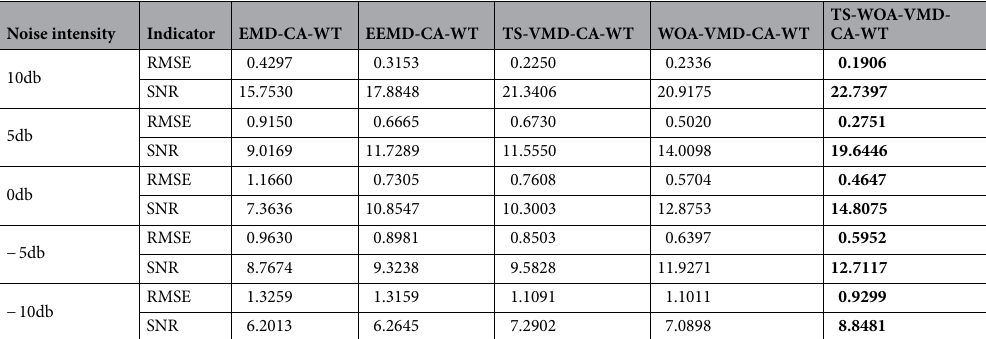
Table 3. The denoising effect of five methods for mixed frequency simulation